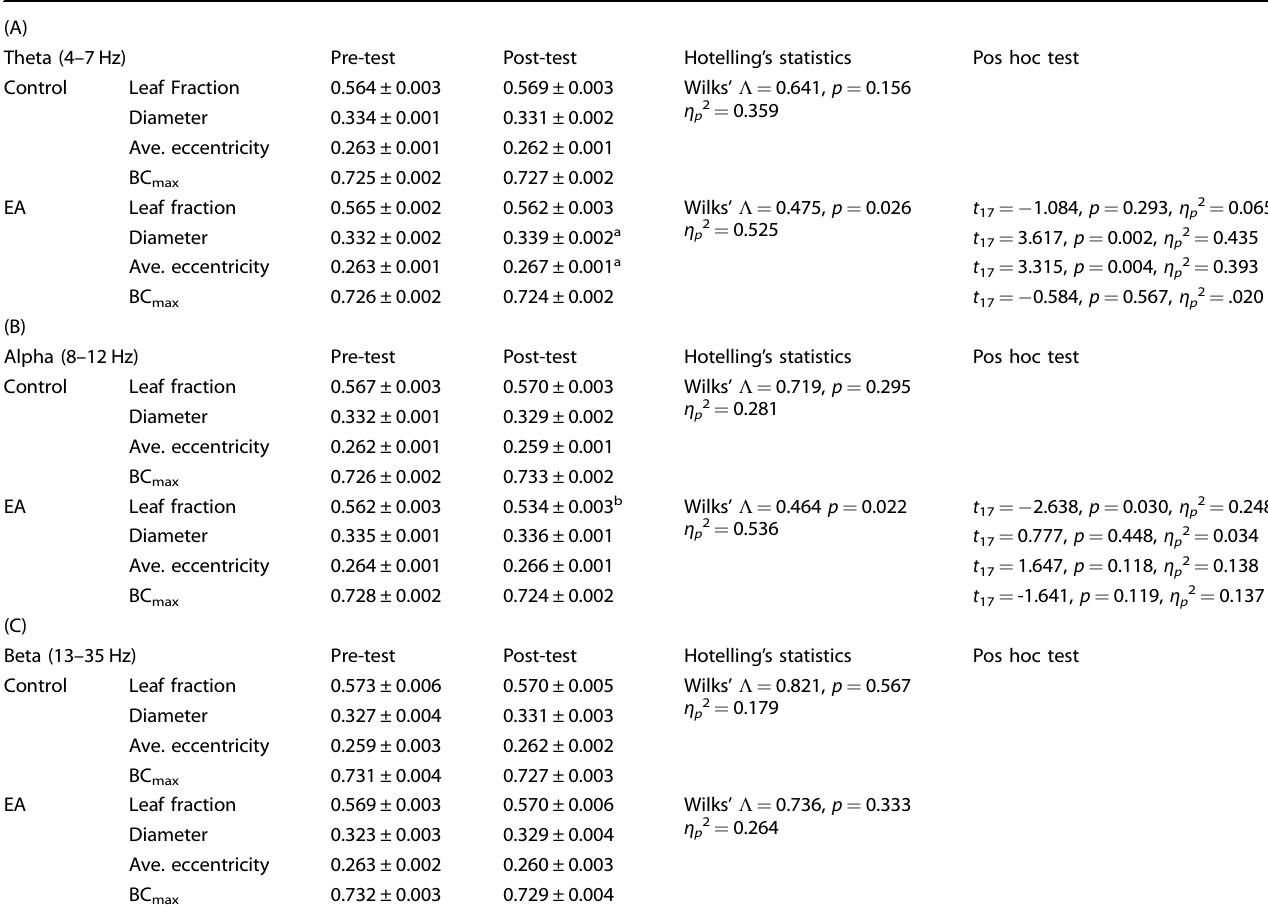
Table 4. The comparison of network graph measures at different spectral bands between the pre-test and post-test for the error ampli fi cation (EA) and control